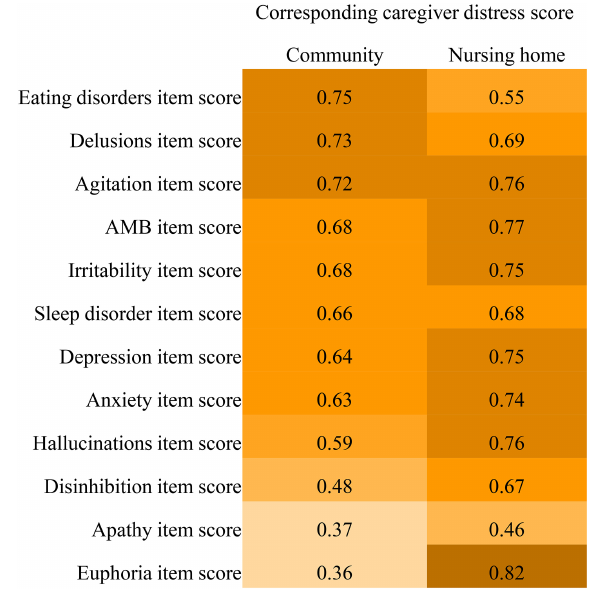
on the way staff behave toward residents with dementia